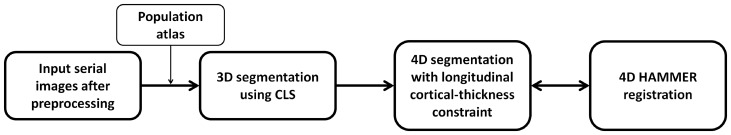
The proposed framework for the 4D brain segmentation.